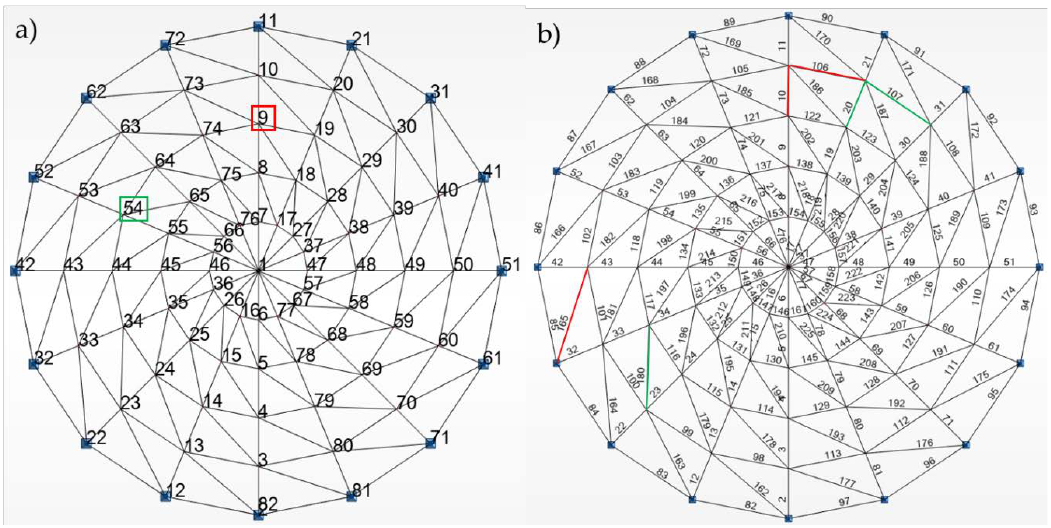
Figure 10. Schwedler dome geometry: ( a ) nodes, ( b ) elements (by green—case 1; by red—case 2).